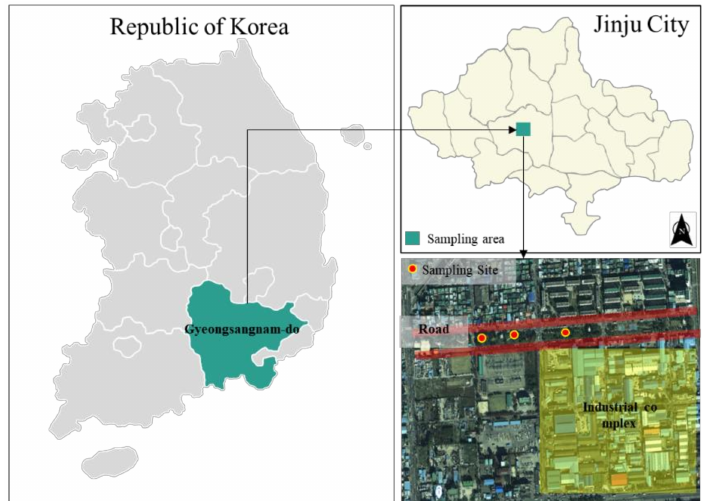
Figure 1. Location of sampling area (Google